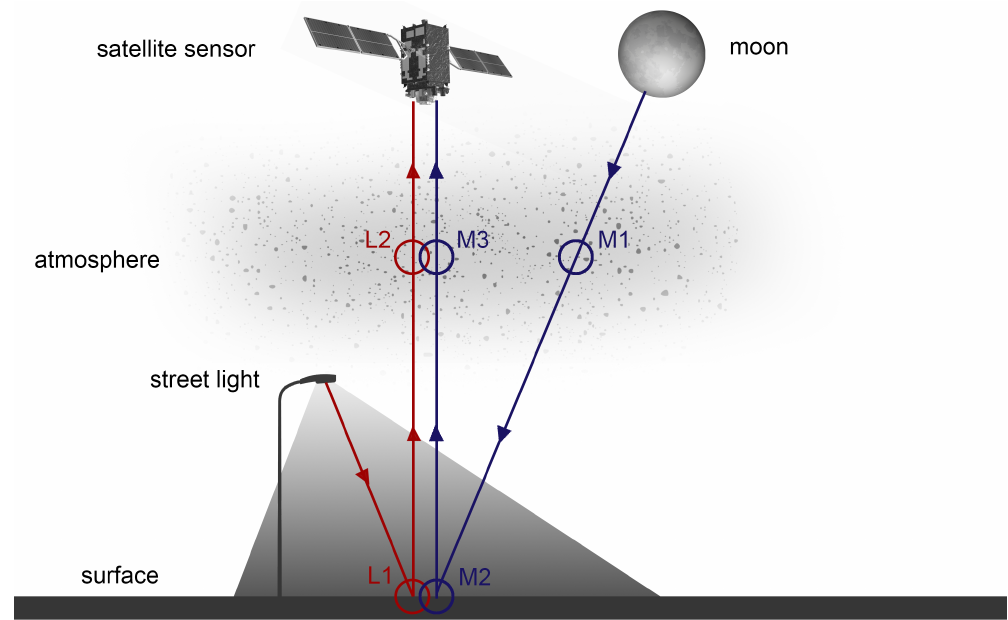
Figure 1. Model of propagation of nighttime radiation in optical remote sensing (under cloud-free conditions) with: (M1) downward atmosphere interaction with moon electromagnetic (EM) waves; (M2) surface interaction with moon EM waves; (M3) upward atmosphere interaction with moon EM waves; (L1) surface interaction with lamp EM waves; (L2) upward atmosphere interaction with lamp EM